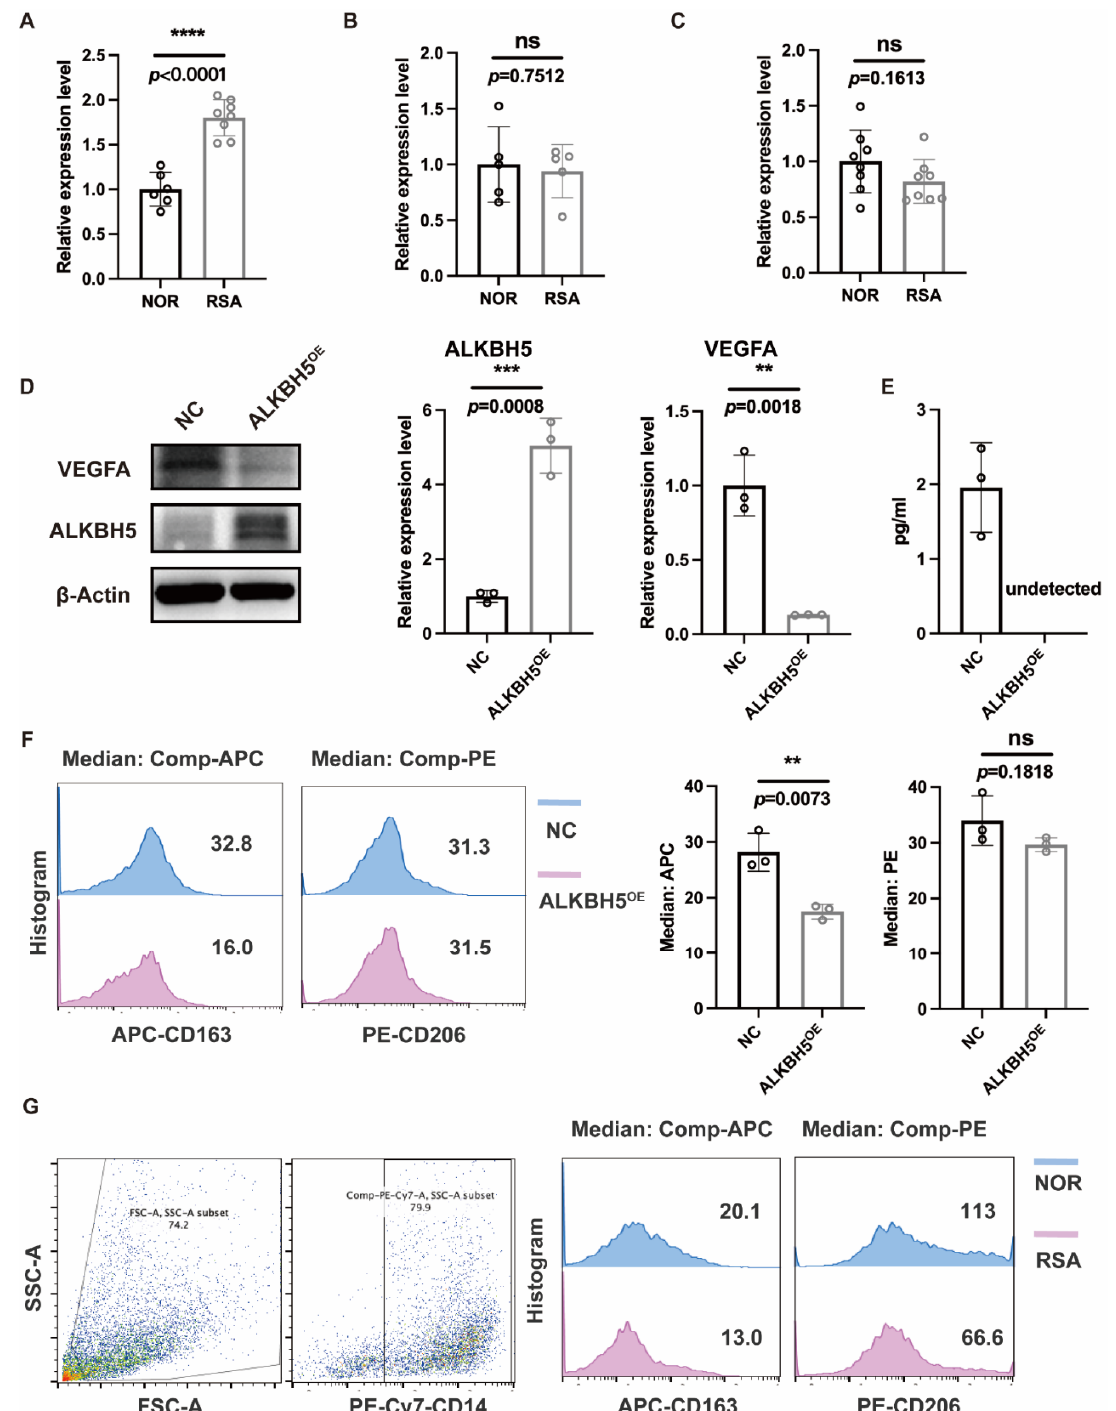
Figure 9. ALKBH5 altered macrophage differentiation status via VEGF secretion . ( A ) mRNA expression level of ALKBH5 in primary human DSCs. ( B ) mRNA expression level of ALKBH5 in primary human decidual NK cells. ( C ) mRNA expression level of ALKBH5 in primary human decidual macrophage. ( D ) Protein level of ALKBH5 and VEGFA in ALKBH5 ‐ overexpression ESC line. ( E ) VEGF concentration of ALKBH5 ‐ overexpression ESC line supernatant. ( F ) CD163 and CD206 median fluorescence intensity of THP ‐ 1 after co ‐ culturing with ALKBH5 ‐ overexpression ESC line. ( G ) CD163 and CD206 median fluorescence intensity of primary human decidual macrophage. **: p < 0.01, ***: p < 0.001, ****: p < 0.0001, NS: Non ‐ significance.